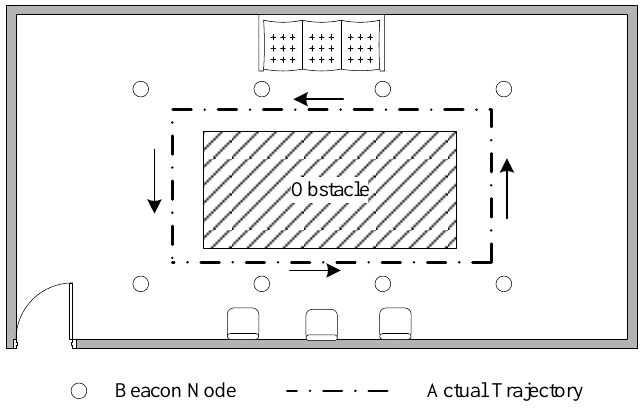
Figure 21. The practical environment.